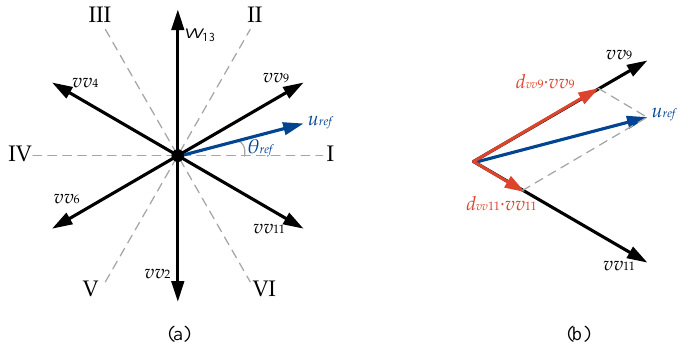
Figure 9. Space vector modulation in α - β subspace: ( a ) sector division; ( b ) modulation in sector I.